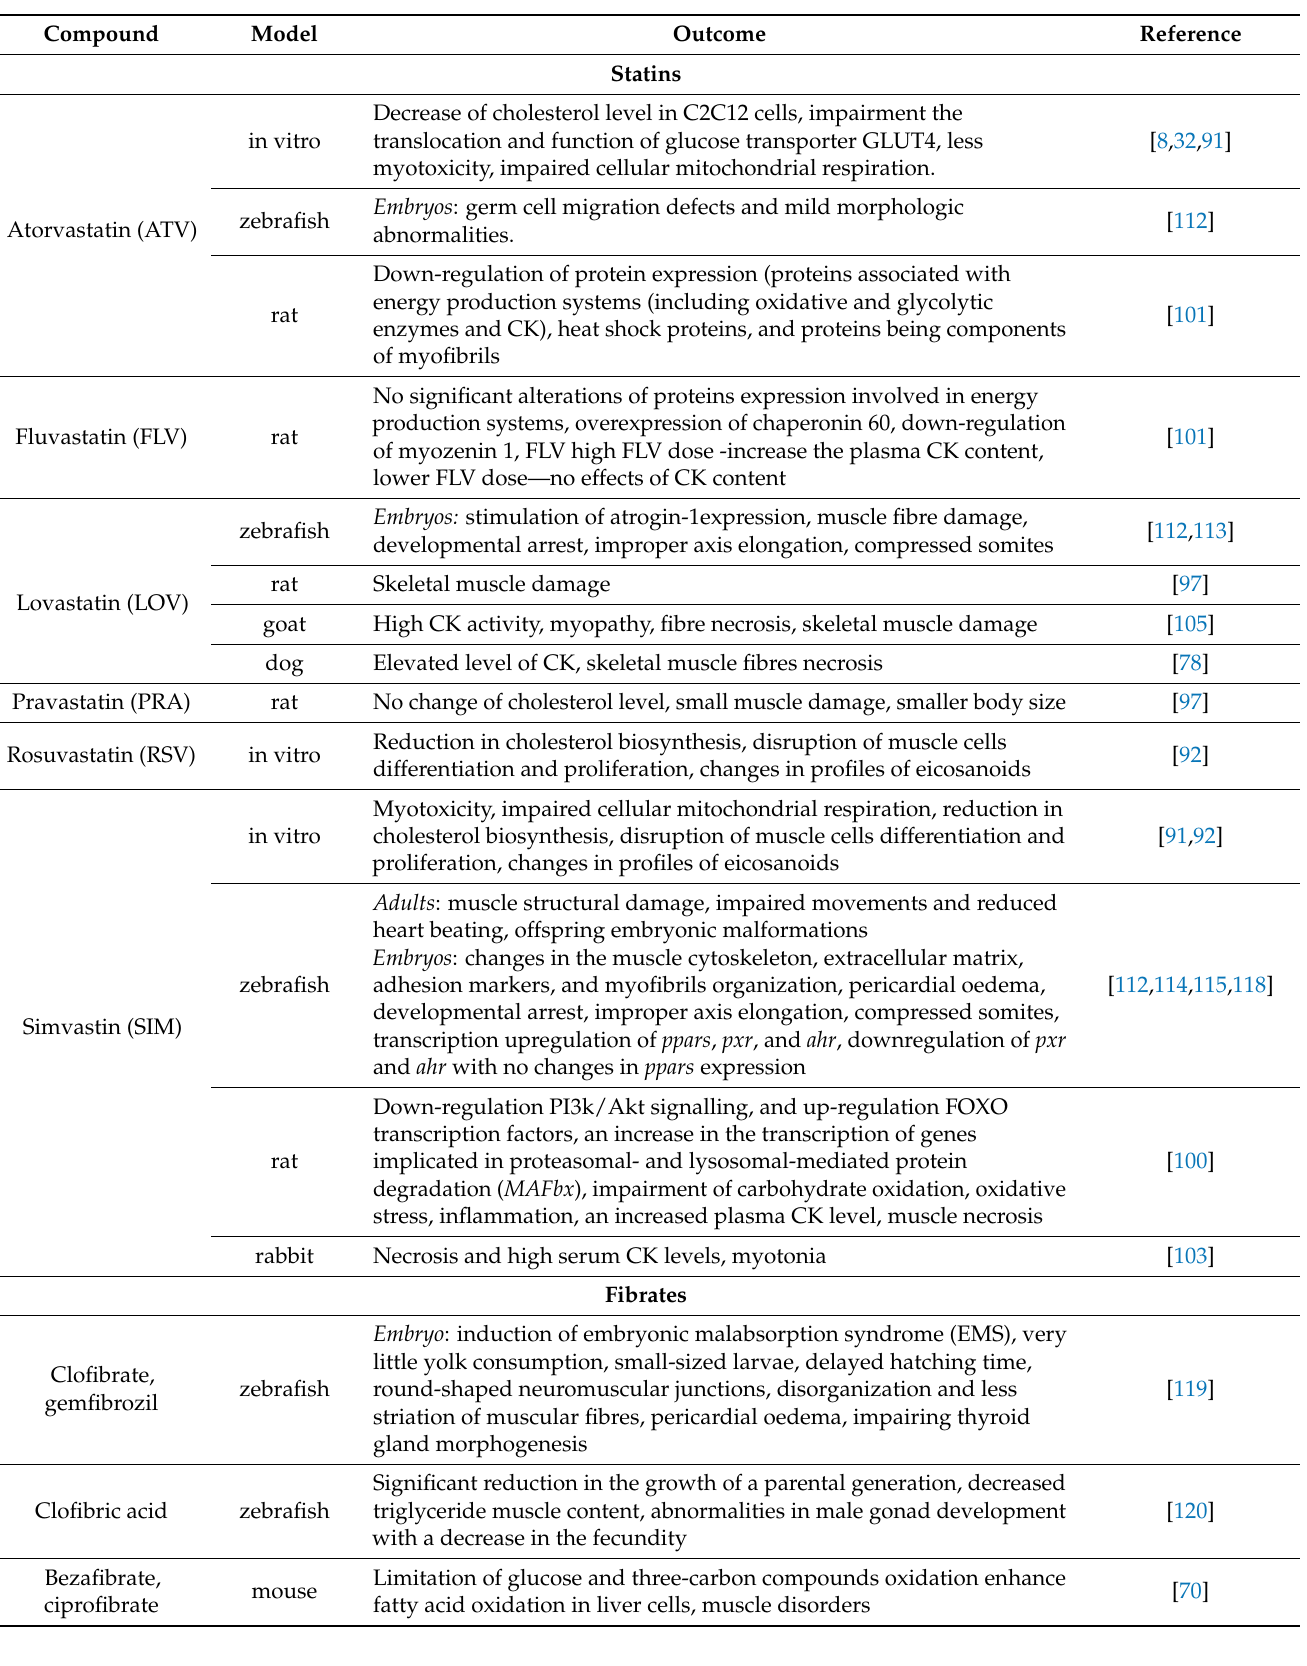
Table 1. List of LLDs in studies using in-vitro and animal